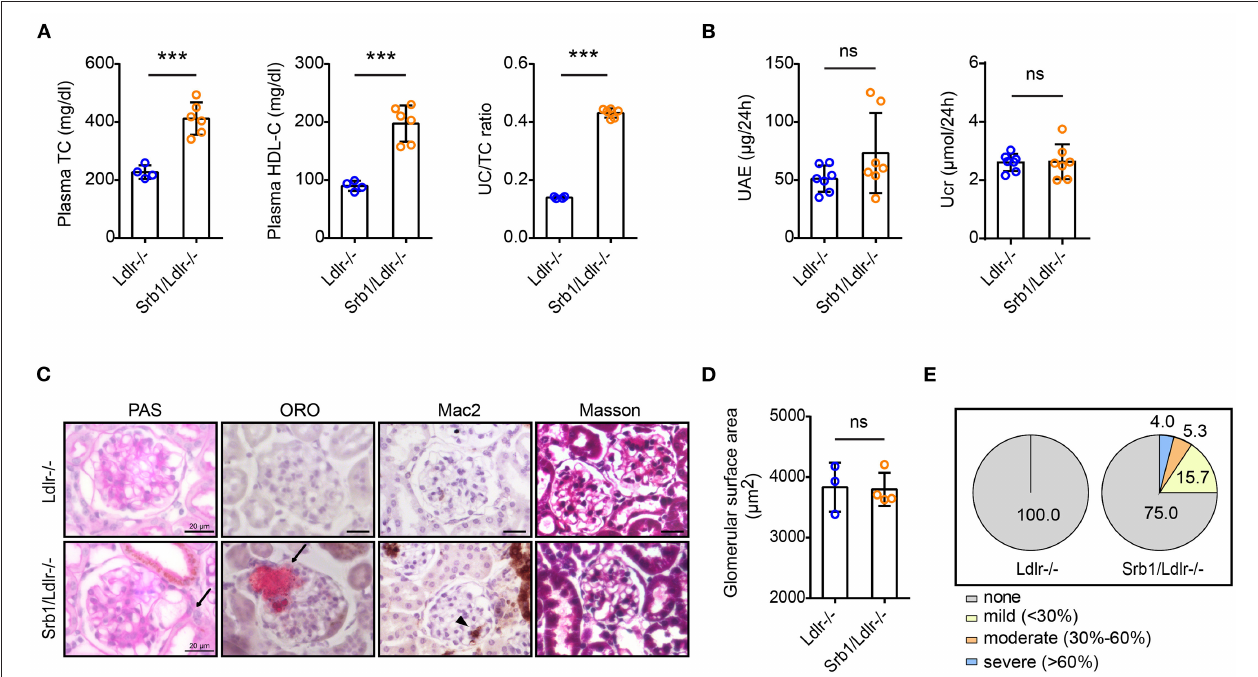
FIGURE 3 | Plasma lipid parameters and renal function/histology in Srb1/Ldlr-/- and Ldlr-/- mice fed on standard chow diet. (A) Plasma TC levels, HDL-C levels, and UC/TC ratios; (B) 24-h UAE and Ucr; (C) Representative glomeruli stained with PAS, ORO, Mac2, and Masson. The arrows indicate foam-like lipoproteins. The triangle indicates macrophages; (D) Glomerular surface area; (E) Quantitation of ORO-positive lipoprotein deposition. n = 3–7 per group. *** : p < 0.001; ns: no